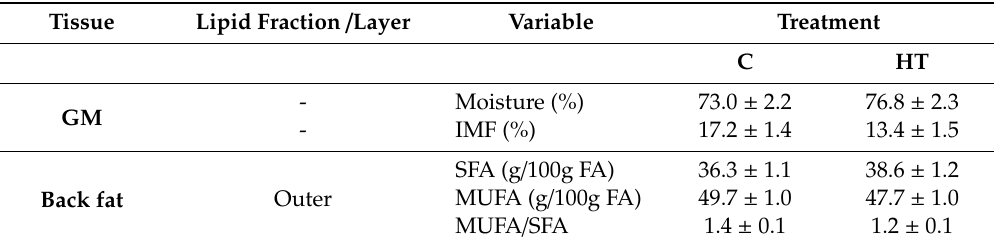
Table 2. Mean values ( ± S.E.M.) of the fatty acids composition of tissues in 180 days-old pigs born from sows treated or not with hydroxytyrosol (groups HT and C, respectively). All values are significantly di ff erent between treatments ( p < 0.05).